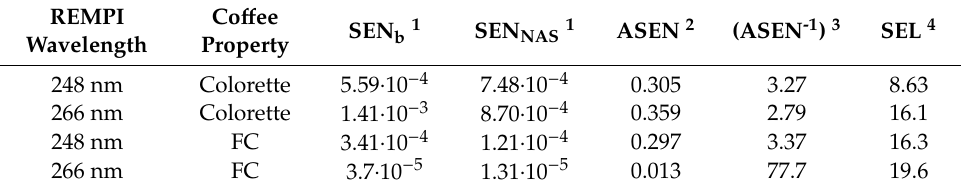
Table 2. Figures of merit: Sensitivity and